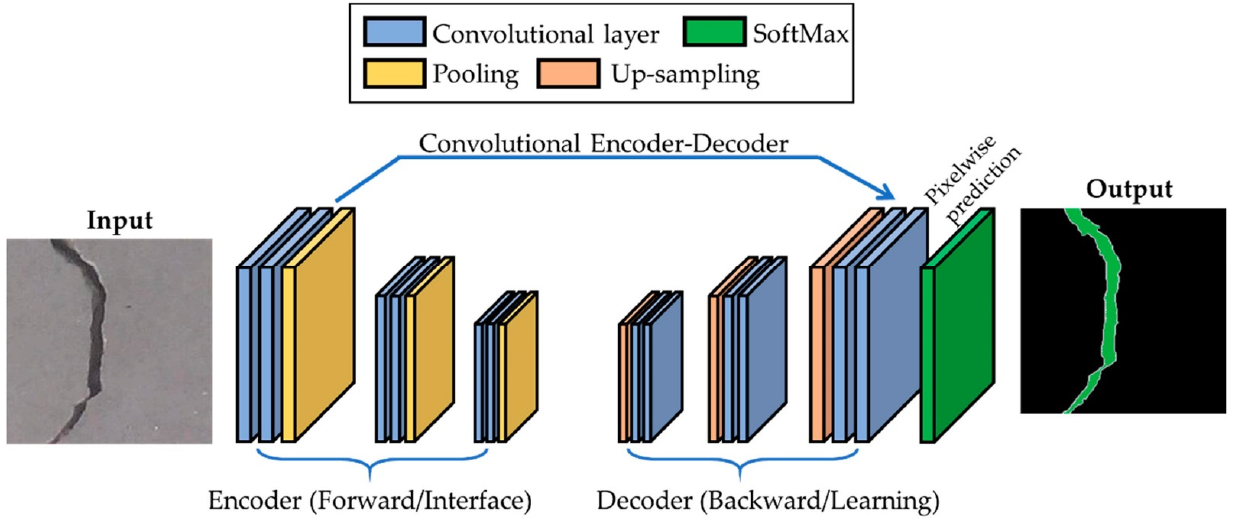
Figure 3. Block diagram of the proposed fully convolutional network (FCN) with the encoder– decoder framework. Reprinted from Ref. [60] with permission of Sensors, 2018.